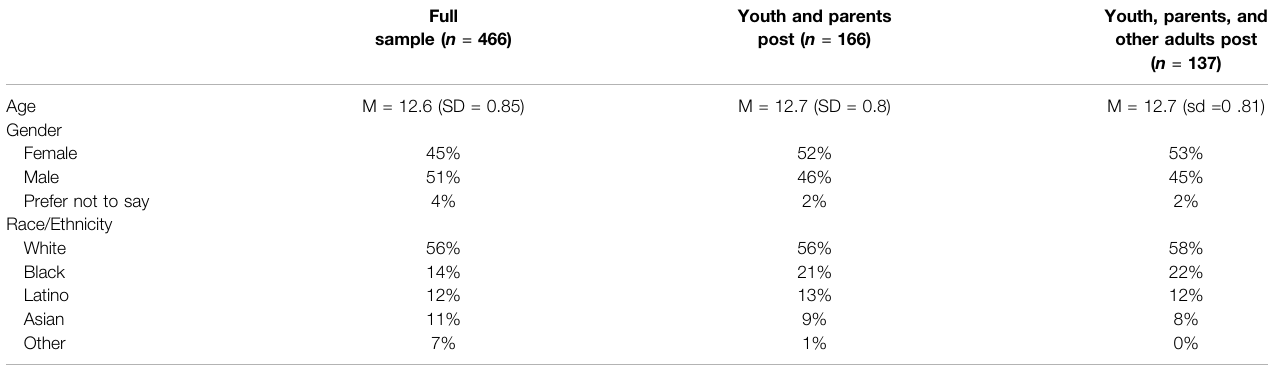
TABLE 1 | Demographic characteristics of participants.